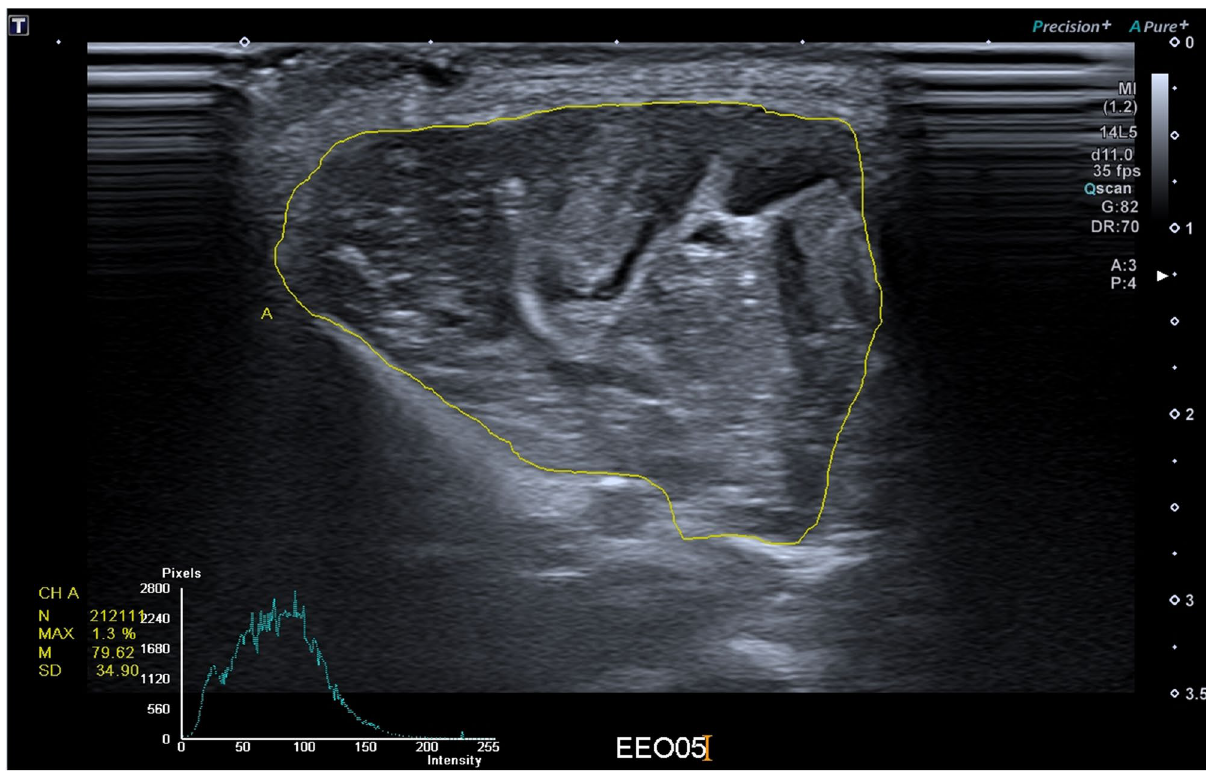
Figure 10. B mode image for calculating echogenicity with the freehand trace of the